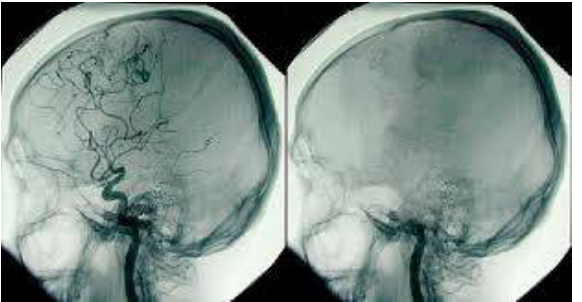
Figure 2. Cerebral Angiogram showing normal blood supply on the left and no blood supply on the right. Photo Source: Australian Donor Awareness Programme and Training (ADAPT).